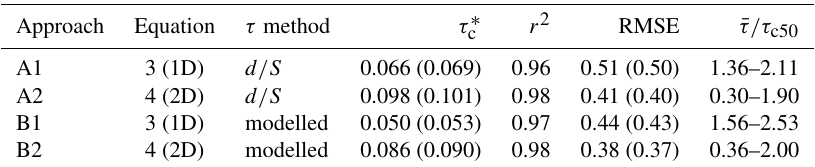
Table 4. Optimised values of τ ∗ c and goodness-of-fit statistics for correlations between excess shear stress and observed bedload transport using four different approaches. Values obtaining using the exponent 1.5 are presented in parentheses, and ¯ τ/τ c50 represents the range of relative shear stress values across the experiments.